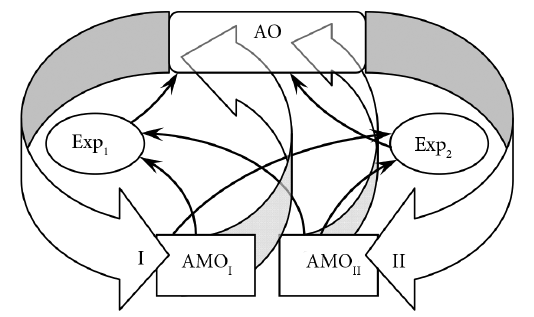
Fig. 1. Information-resource flow-chart diagram of aircraft fleet distribution between two maintenance